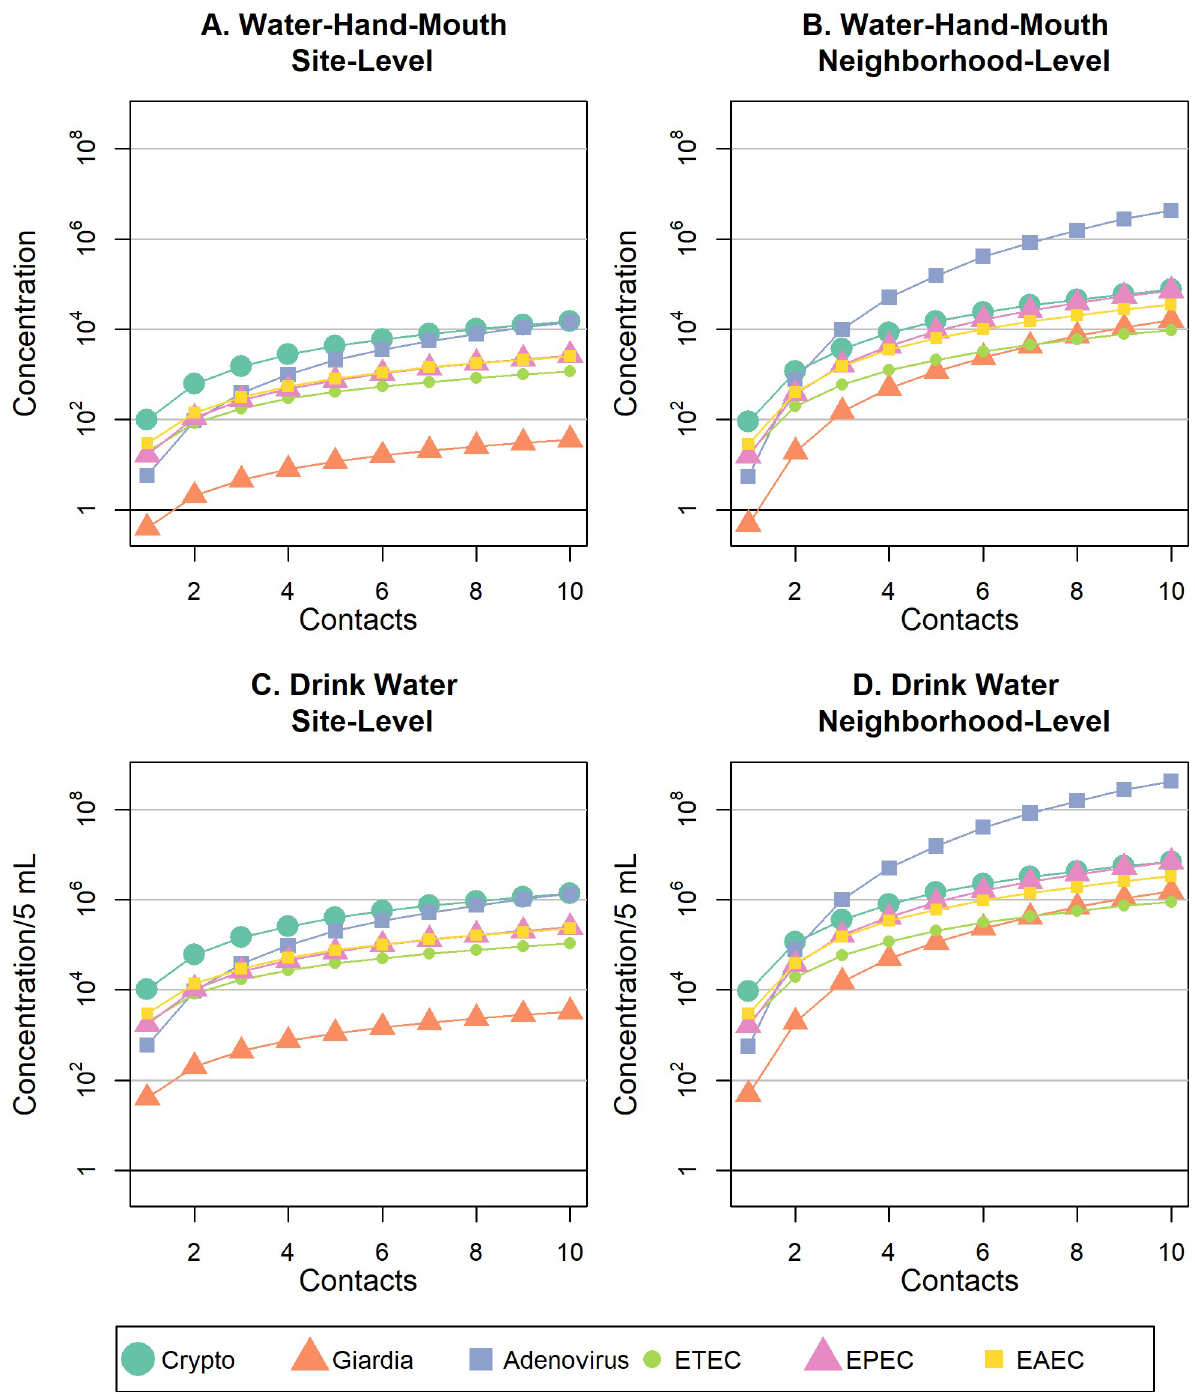
Fig 3. Mean dose of six enteric pathogens ingested with increased frequency of hand-to-mouth or surface water drinking behaviors at site- restricted versus neighborhood levels of spatial scale. Mean pathogen doses are shown for (A) water-hand-mouth exposure behaviors at a single residential public site; (B) water-hand-mouth exposure behaviors at two or more residential public sites within a neighborhood; (C) drinking surface water behaviors at a single residential public site; (D) drinking surface water behaviors at two or more residential public sites within a neighborhood.